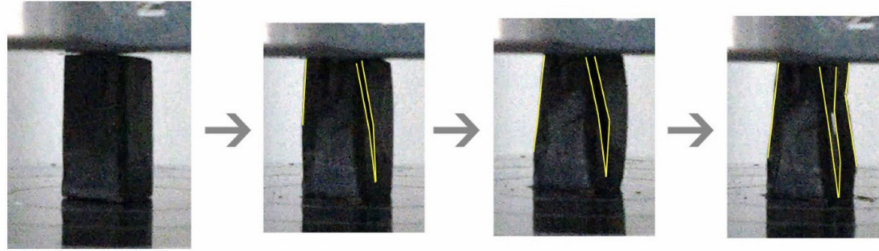
Figure 11. Cracking or fracturing process of brittle material (sample S23) under